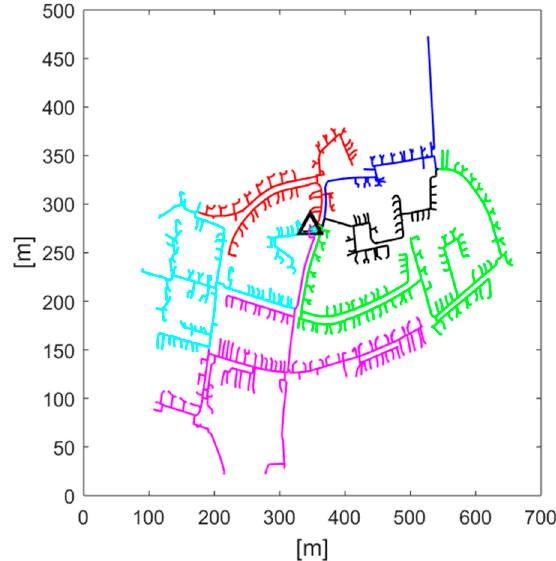
Figure 3. Schematic for the studied network with six LV Feeders (each LV feeder is presented with different color).